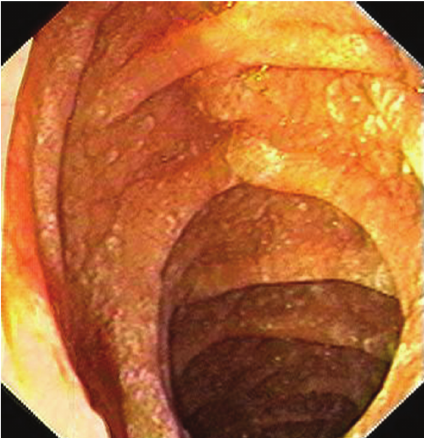
Figure 7: Whipple’s disease: irregular rugged surface of the jejunal mucosa with an appearance like being dusted with